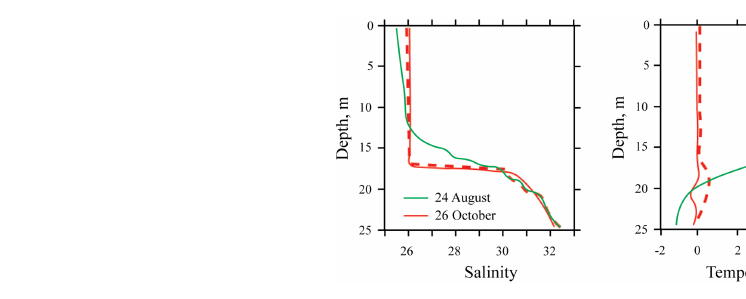
FIGURE 10 Vertical salinity (left) and temperature (right) structure in the eastern part of the Ob-Yenisei plume in the middle of August (green line) and late October (red lines) according to in situ measurements (solid lines) and numerical modeling (dashed lines). Location of the in situ measurements is shown by the right white arrow in Figure